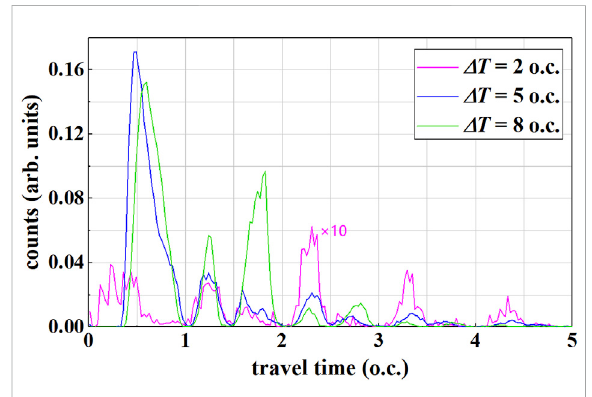
FIGURE 4 The drift time distribution of ionized electrons with the time delay 2 o.c. (pink line, multiply by 10), 5 o.c. (blue line), and 8 o.c. (green line). The results are calculated with 2 × 10 8 initial